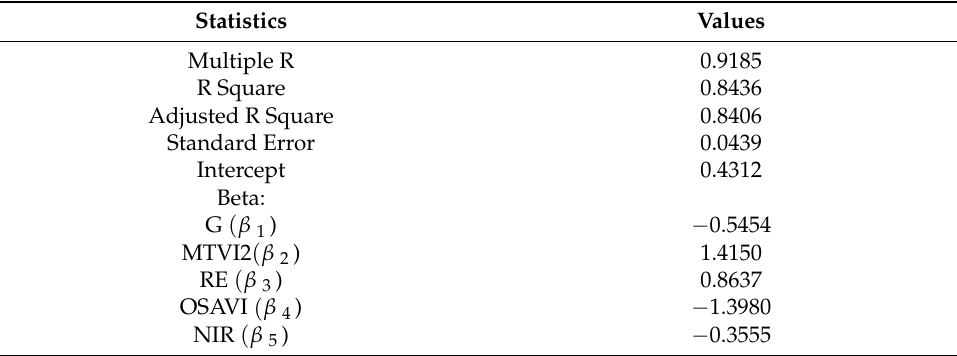
Table 6. Summary statistics of multiple linear regression models.